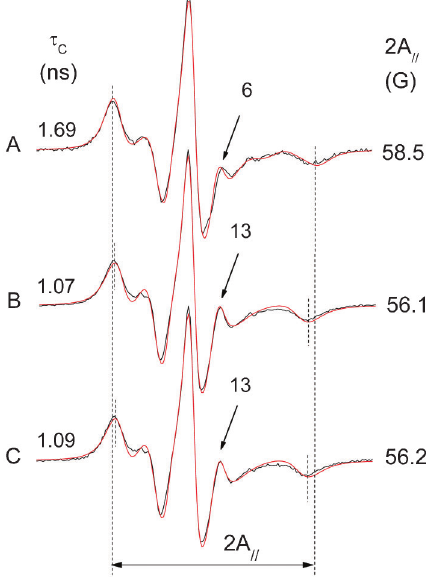
Figure 4. Experimental (black line) and best-fit (red line) EPR spectra of 5-DSA in erythrocyte ghost membranes: A , oxidized with 50 mM AAPH; B , control sample (not oxidized); C , a sample pre- treated with 100 m M 4-NC and then oxidized (50 mM AAPH). The EPR parameter 2A // represents the separation in magnetic-field units between the first and last resonance lines of the spectrum. The vertical lines indicate the 2A // for the oxidized sample (the total magnetic field scan range of the spectrum was 100 G). The values of both the 2A // and the rotational correlation time ( t C ) parameters (shown in the figure for each spectrum) were greater for the oxidized sample, indicating a reduction in molecular dynamics or increased molecular order. Another indication of this loss of probe mobility in the oxidized sample is the smaller relative intensity of the resonance line, which is indicated by an arrow (and intensity value) ineachspectrum.The estimatedexperimental errorsfor 2A // and t C are 0.5 G and 0.2 ns, respectively. EPR: electron paramagnetic resonance; AAPH: 2,2 9 -azobis(2-aminopropane) hydrochloride; 4-NC: 4-nerolidylcatechol. preincubation with the antioxidant 4-NC for 1.5 h at 37 6 C (Figure 4C). The EPR spectra of 5-DSA in RBC ghosts were not altered in the presence of antioxidants 4-NC or a -tocopherol up to a concentration of 100 m M. A small effect in membrane fluidity was observed for these compounds at concentrations approximately 10 times higher.